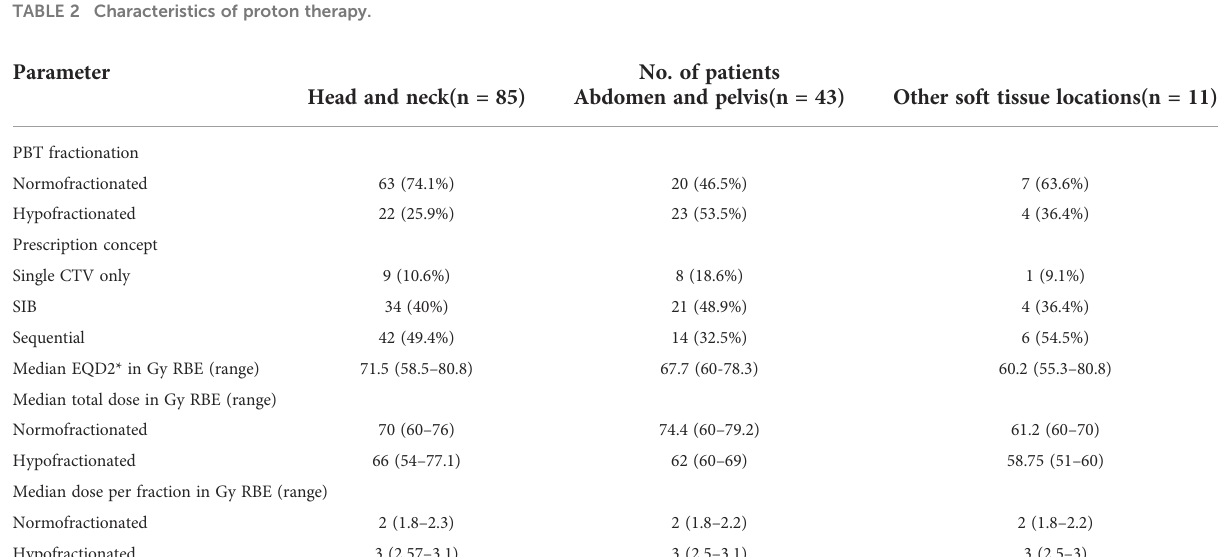
TABLE 2 Characteristics of proton